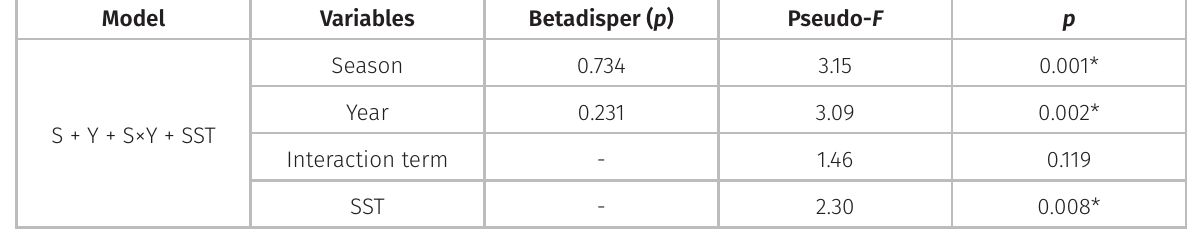
symbols), Year 2: October 2012 to March 2013 (orange symbols). W and E: West and East domains. Stress = 0.11.